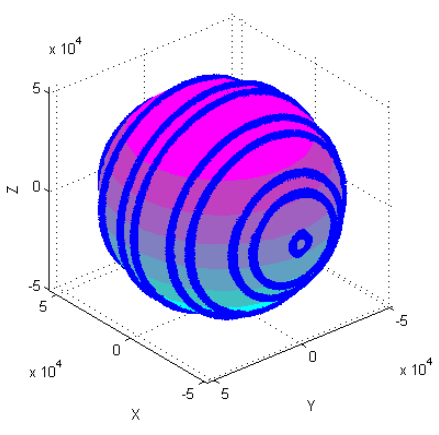
Figure 4. Optimal ellipsoid fitting (EF1). Figure 5. Optimal ellipsoid fitting (EF2). Figure 5. Optimal ellipsoid fitting (EF2). Sensors 2018 , 18 , x